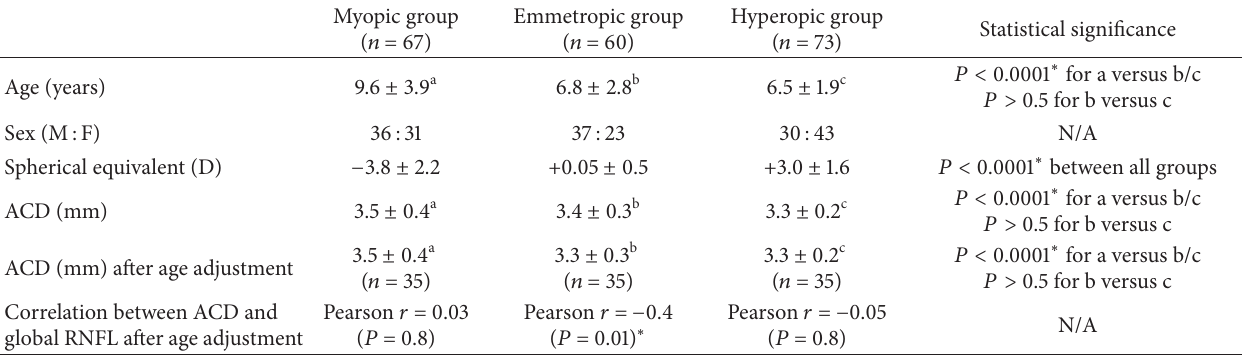
Table 3: Differences in age, spherical equivalent, axial length, and anterior chamber depth in myopic, emmetropic, and hyperopic